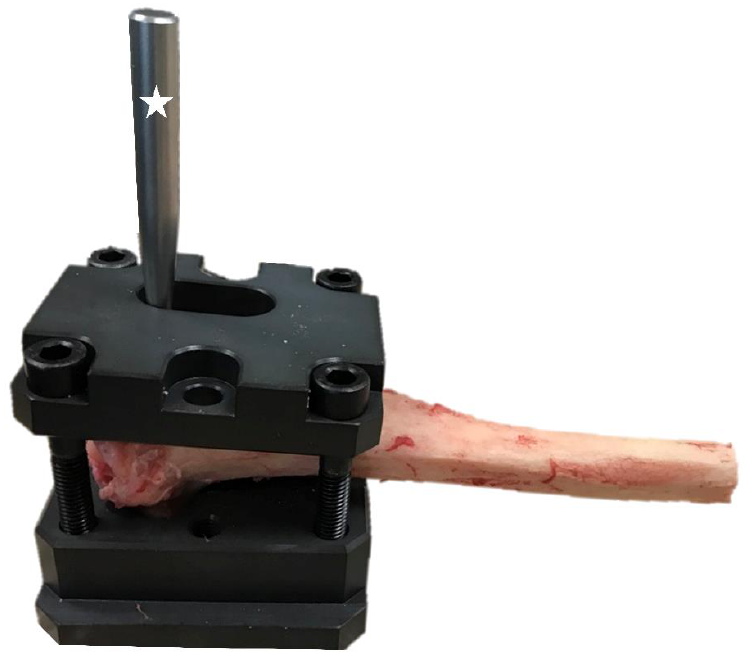
Figure 6. Specimen prepared for mechanical testing. A screwed custom bar is marked with an asterisk.